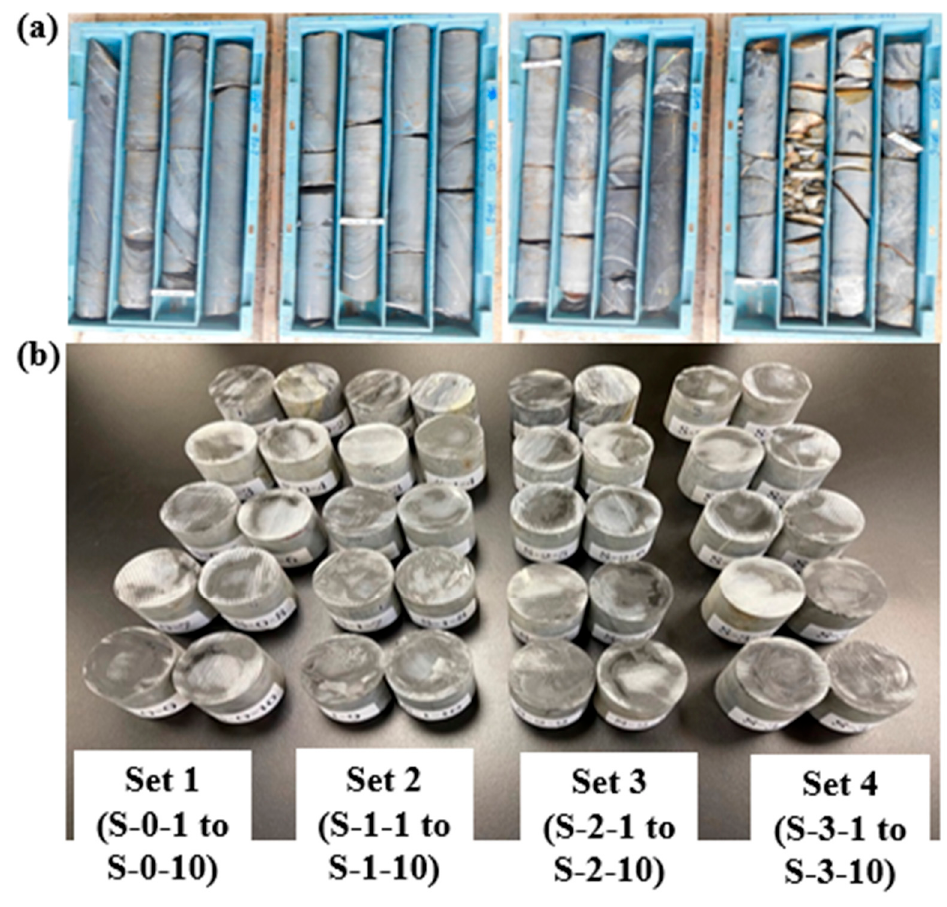
Figure 2. ( a ) Core sample trays; ( b ) prepared representative samples (S-0-1 to S-0-10; samples for room temperature tests, S-1-1 to S-1-10; samples for 400 °C tests, S-2-1 to S-2-10; samples for 600 °C tests, S-3-1 to S-3-10; sample for 800 °C tests.